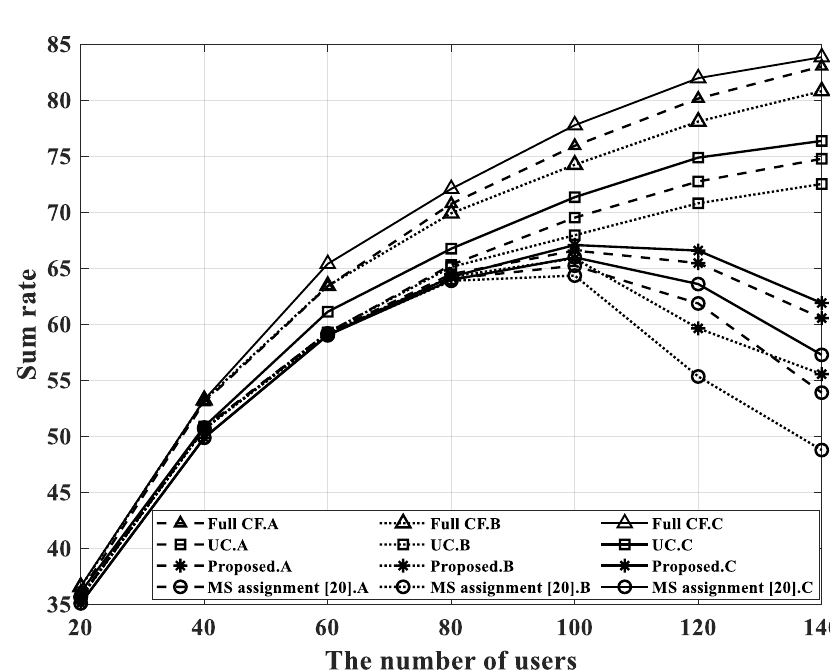
Figure 5. Sum rate performance for four